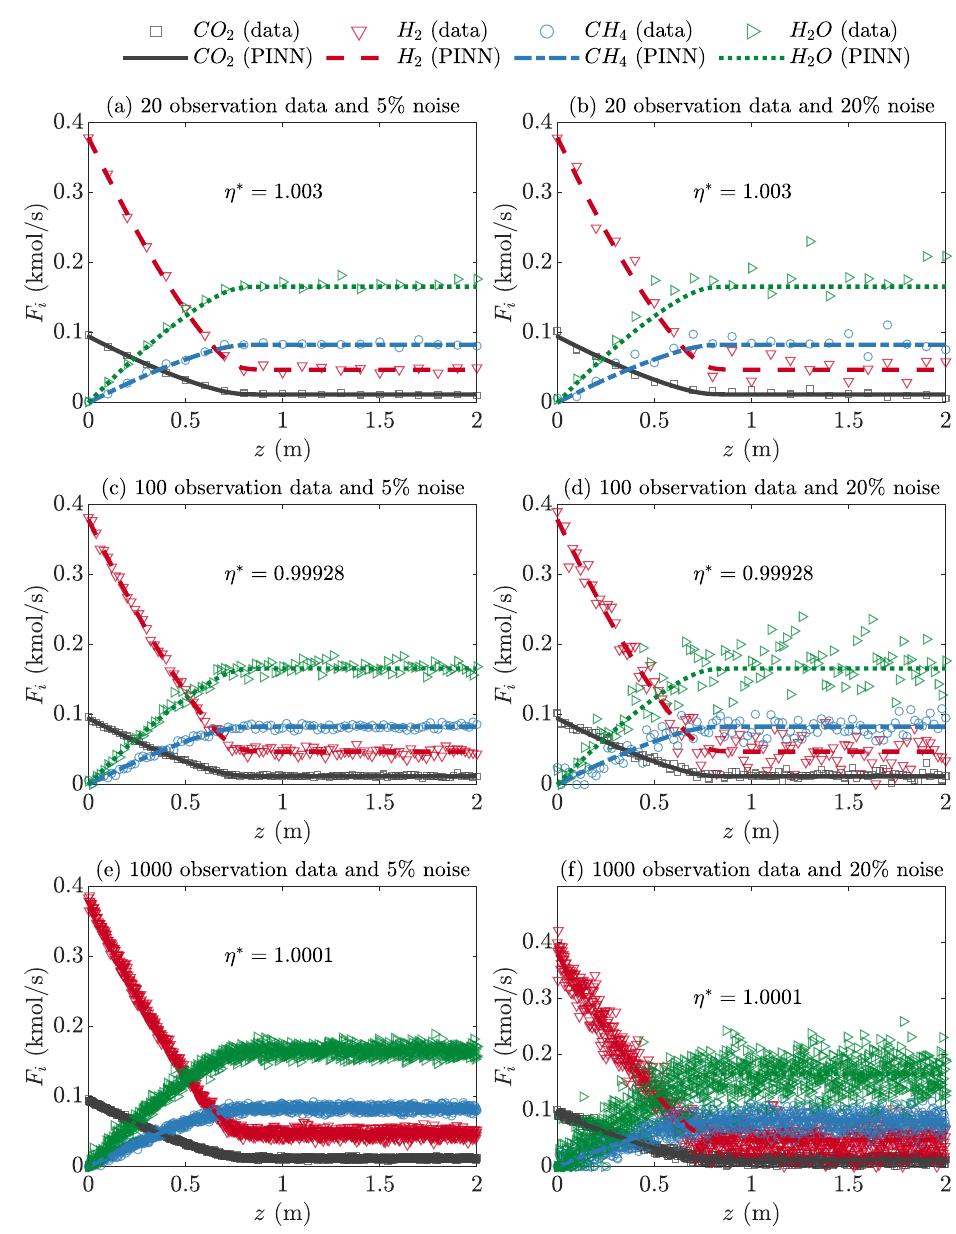
Figure 10. Influence of the number of observation data points ( N obs ) and noise ratios on the identifi- cation performance of the effectiveness factor ( η ) of an inverse PINN with seven layers, 256 neurons per layer, and the tanh activation function: ( a ) 20 data and 5% noise, ( b ) 20 data and 20% noise, ( c ) 100 data and 5% noise, ( d ) 100 data and 20% noise, ( e ) 1000 data and 5% noise, and ( f ) 1000 data and 20% noise.